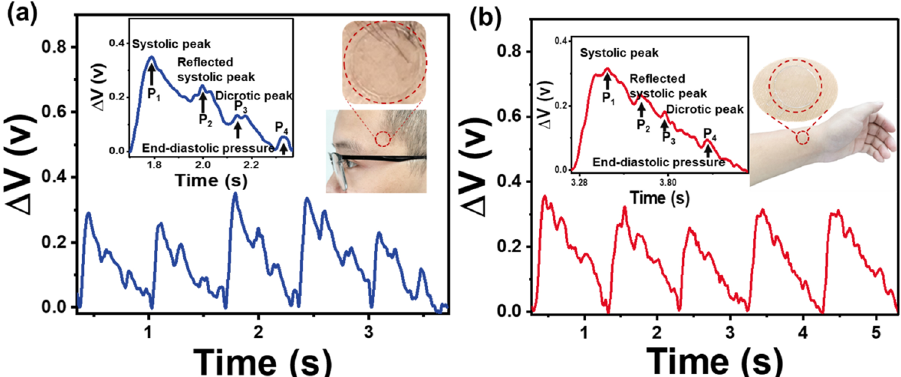
Fig. 7 The demonstration of invisible tactile AI. a The pulse wave signal collected by the TIS device at temple, the inserted image illustrates the detailed waveform of single pules wave, b the pulse wave signal collected by the TIS device at wrist, the inserted image illustrates the detailed waveform of single pules